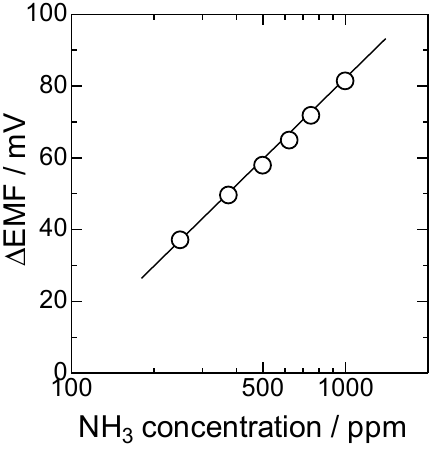
O (850) electrode as a function of NH 2 3